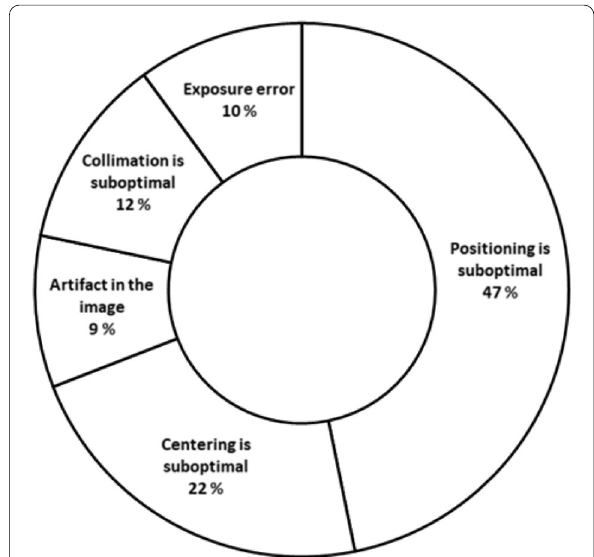
Fig. 1 Overview of main reasons for rejection of images